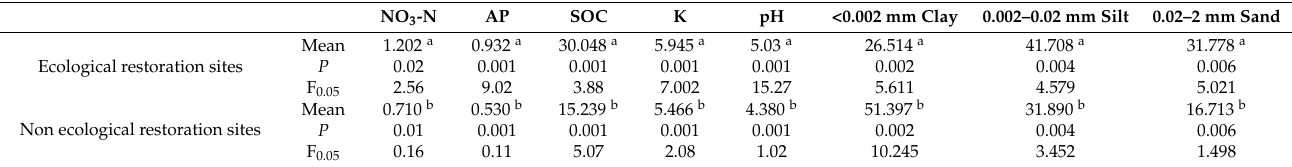
Table 1. Soil physical and chemical properties (%).